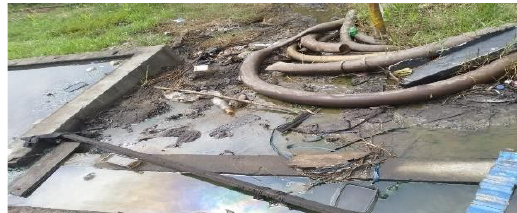
Photograph showing the effect of sludge, scales and waste muds (especially oil-based mud) on the enhancement of radioactivity concentration and environmental faunal and floral